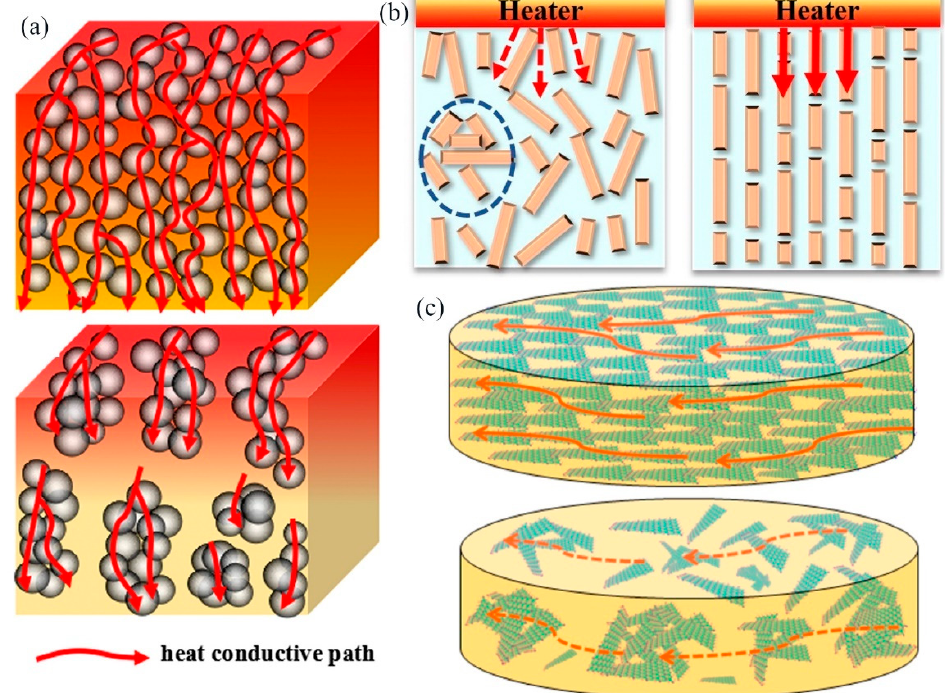
Figure 2. Dispersion of ( a ) 0-D, ( b ) 1-D, and ( c ) 2-D fillers in matrices (reproduced with permission from [28,79,96]).